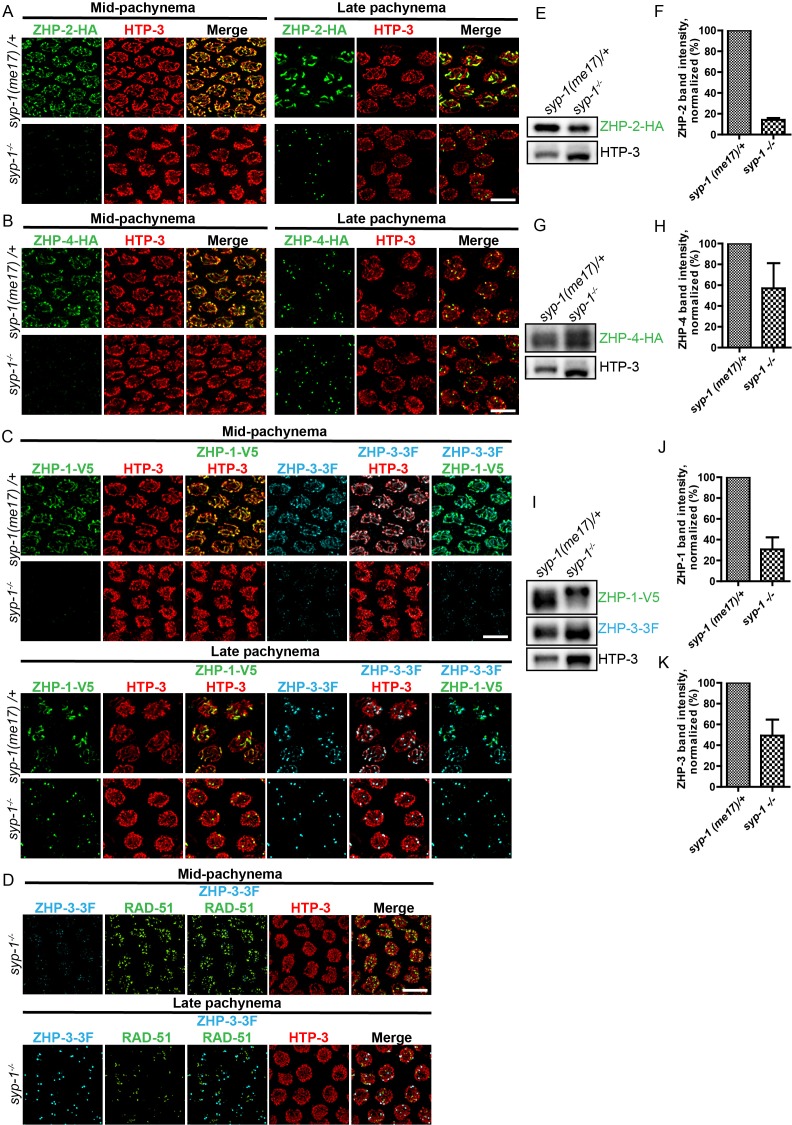
Localization of the ZHPs along meiotic chromosomes depends on SCs.(A,B) Projection images of mid- and late pachytene nuclei, showing the localization of ZHP-2-HA (A) and ZHP-4-HA (B) in syp-1 mutant hermaphrodites and heterozygous controls. Chromosome axes are marked by HTP-3 (red). (C) Projection images of mid- and late pachytene nuclei showing the localization of ZHP-1-V5 (green) and ZHP-3-3xFLAG (cyan) in syp-1 mutants and control animals. Chromosome axes are marked by HTP-3 (red). Association of ZHPs along chromosomes was abolished in the absence of synapsis. (D) Projection images of mid- and late pachytene nuclei showing the localization of ZHP-3-3xFLAG (cyan) and RAD-51 (green) in syp-1 mutants. Chromosome axes are marked by HTP-3 (red). The nuclear puncta of ZHP-3 do not colocalize with DSB repair sites. Scale bars, 5 µm. (E,G,I) Western blots showing the abundance of ZHP proteins in syp-1 mutants and control worms. Protein from an equal number of animals was loaded in each lane, and HTP-3 was blotted as a loading control. (F,H,J,K) Quantification of Western blots. The ZHP band intensity was normalized against HTP-3 and expressed as percentage of the intensity in a control sample. Data are presented as mean ±SD protein levels from three independent experiments.